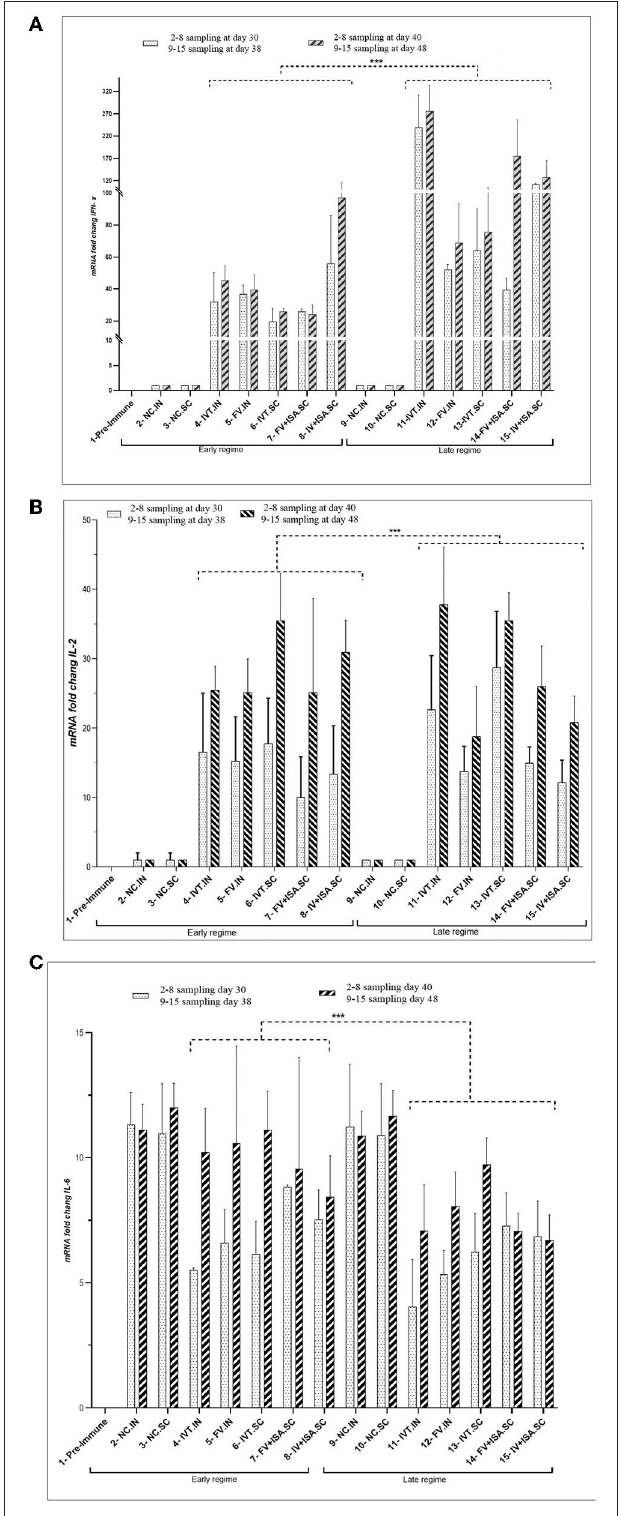
FIGURE 5 | The cytokine assay (A) IFN- γ , (B) IL-2, and (C) IL-6 (cytokines mRNA transcription levels as fold change) in the vaccinated broiler chicken groups in the second animal experiment). Two vaccination regimes were